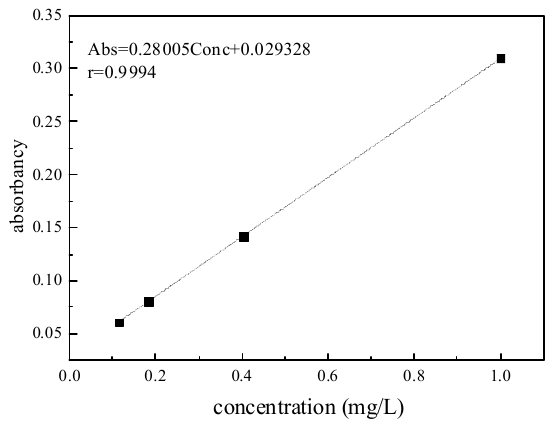
Figure 1. Standard solution curve of Zn.